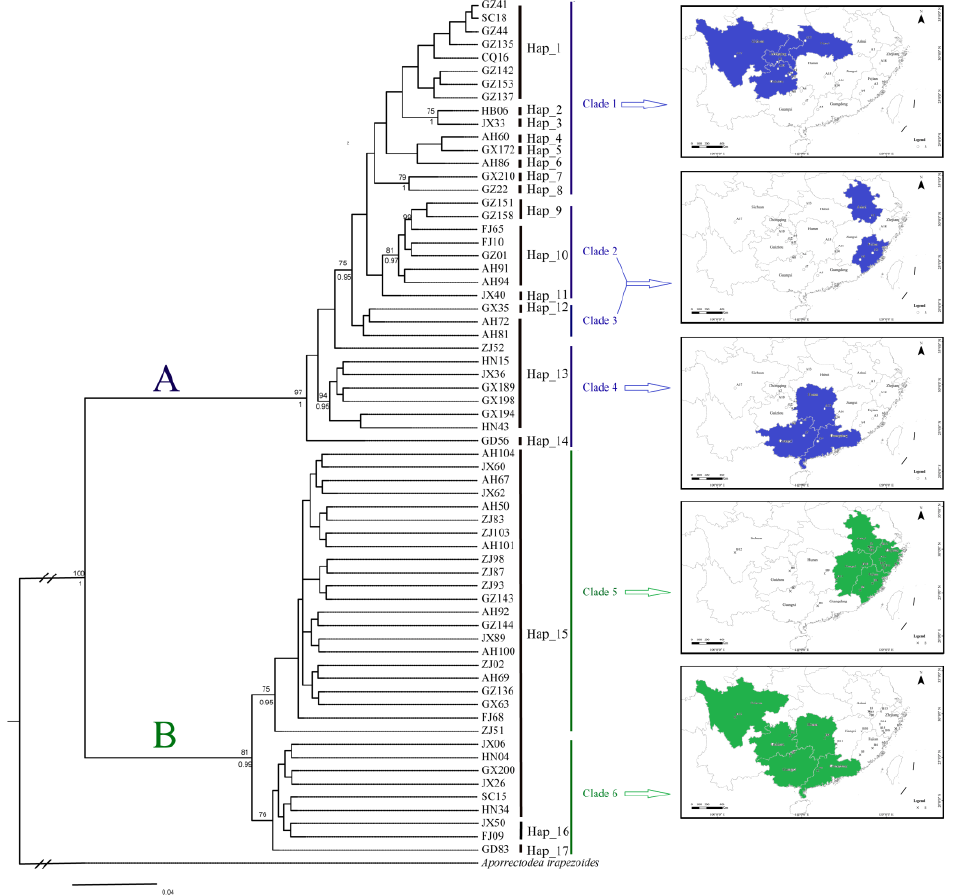
Figure 2. Phylogenetic trees reconstructed using different methods (ML and BI) based on the COI gene. Branch lengths are proportional to the amount of change along the branches. Bootstrap proportions (if ≥ 70%) and Bayesian posterior probabilities (if ≥ 0.95) are shown above and below the branches, respectively. Aporrectodea trapezoides was used as the outgroup